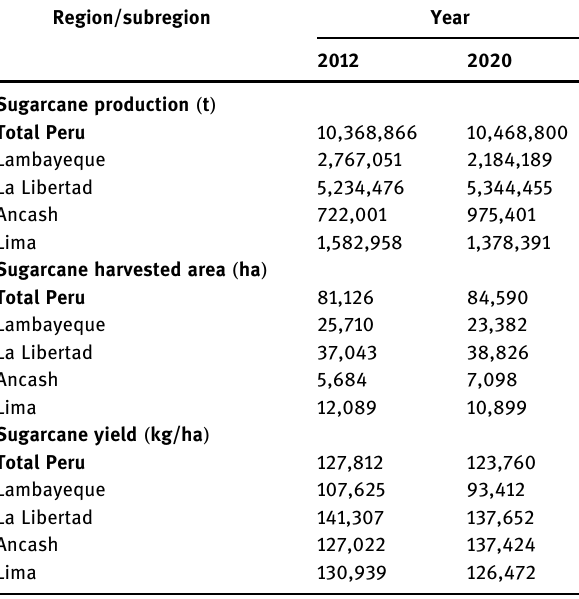
Table 6: Production, harvested area, and yield of sugarcane in